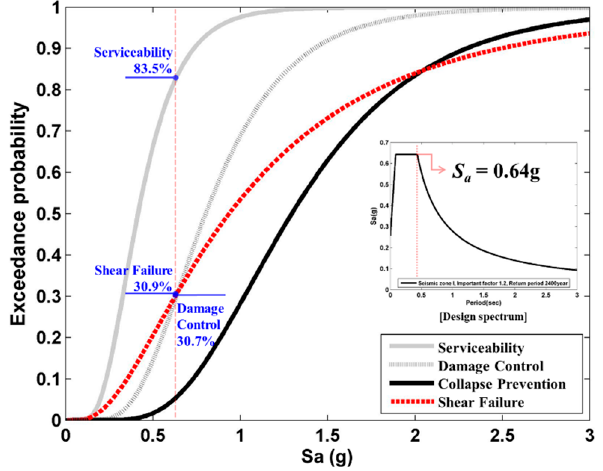
Figure 9. Seismic vulnerability curves at the global and local levels.